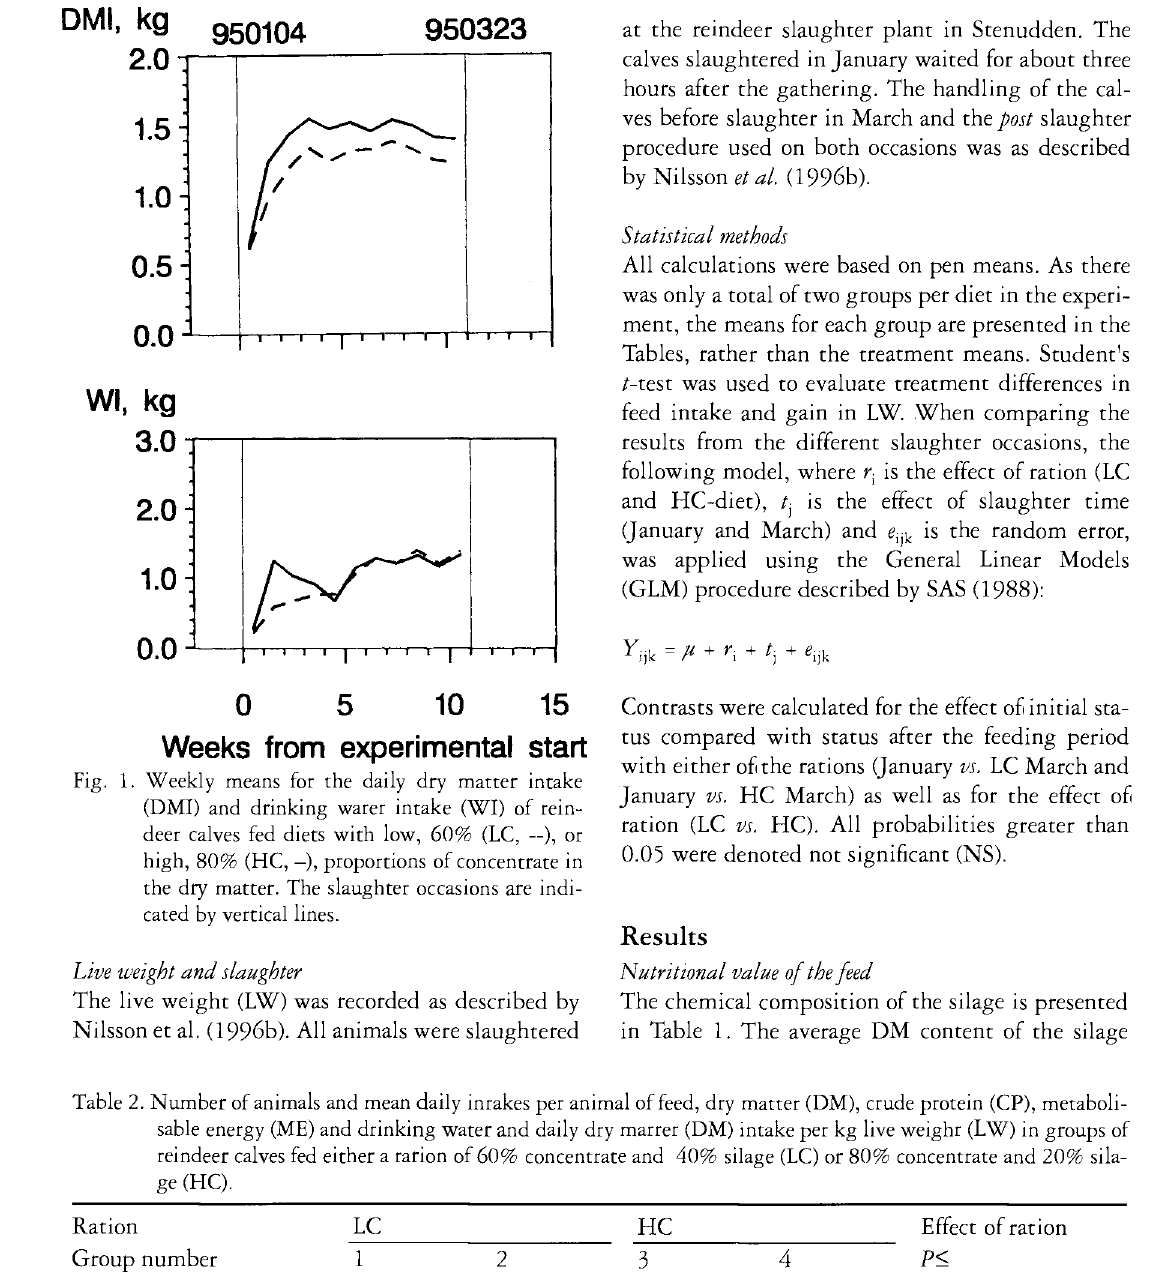
Table 2. Number of animals and mean daily inrakes per animal of feed, dry matter (DM), crude protein (CP), metaboli- sable energy (ME) and drinking water and daily dry marrer (DM) intake per kg live weighr (LW) in groups of reindeer calves fed either a rarion of 60% concentrate and 40% silage (LC) or 80% concentrate and 20% sila¬ ge